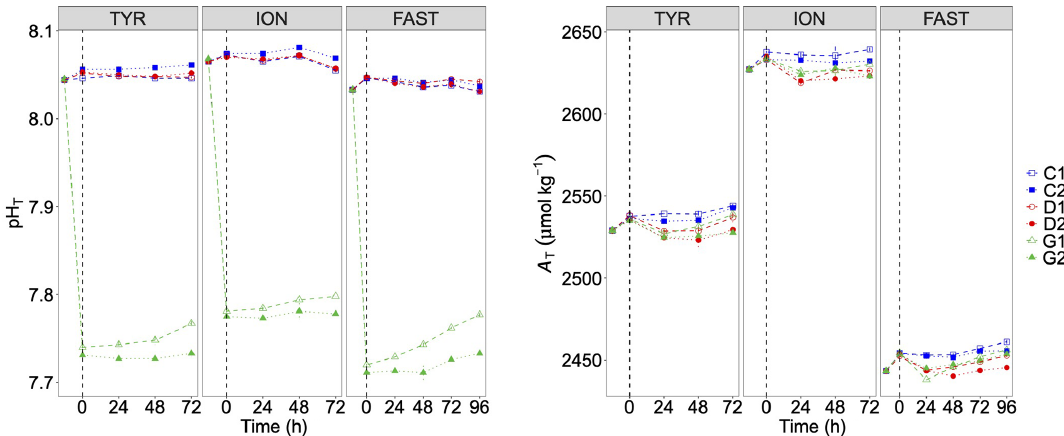
Figure 5. pH on the total scale (pH T ) and total alkalinity ( A T ) measured in the six tanks during the experiments at TYR, ION and FAST. The dashed vertical line indicates the time of dust seeding (after t0). Error bars correspond to the standard deviation based on analytical